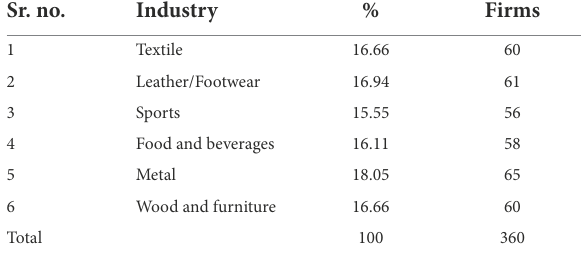
TABLE 1 Industry profile.